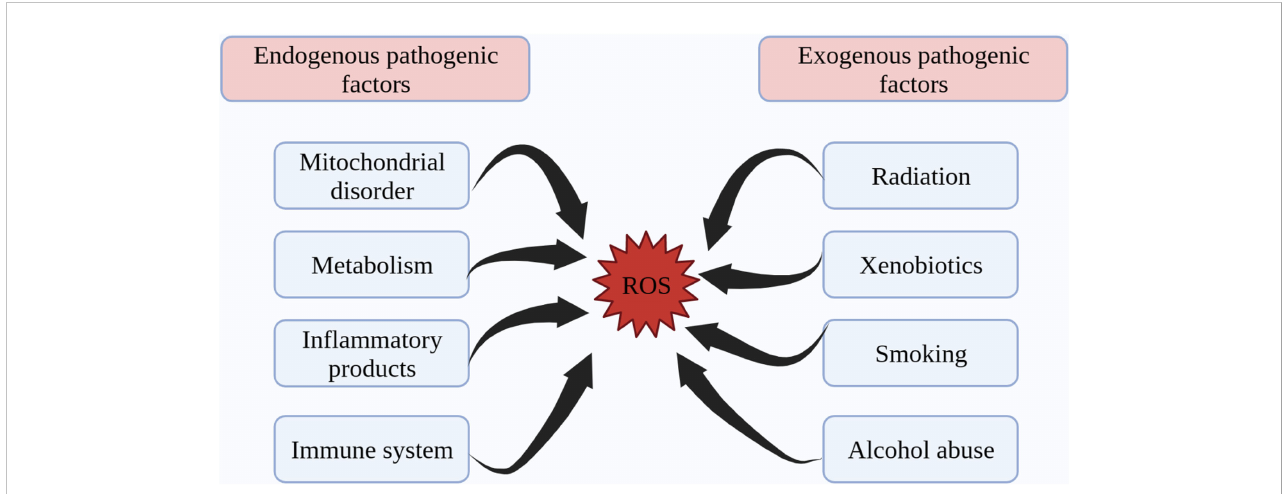
FIGURE 1 Endogenous and exogenous factors in ROS production. ROS generation is divided into two aspects: endogenous pathogenic factors and exogenous pathogenic factors. Endogenous pathogenic factors include mitochondrial disorder, metabolism, in fl ammatory products, immune system, etc. Exogenous pathogenic factors include radiation, xenobiotics, smoking, alcohol abuse, etc. ROS, reactive oxygen